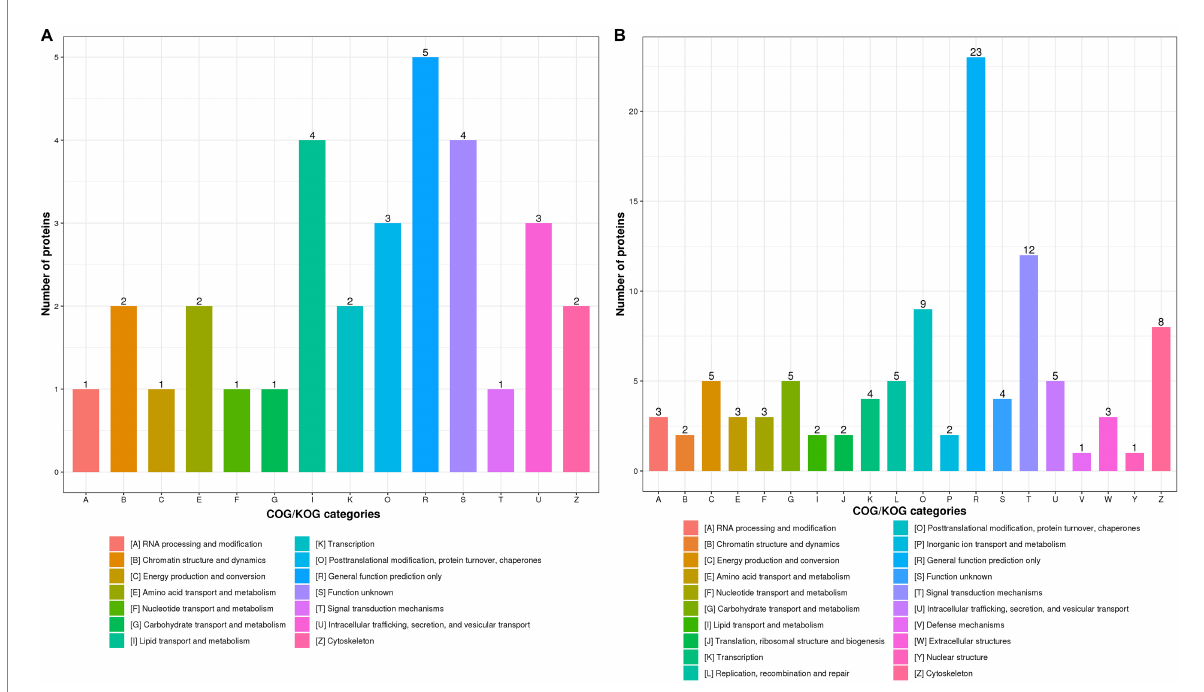
FIGURE 5 COG/KOG functional classification distribution maps of DEPS in WT and KO mice lung tissues infected with PR8 virus at 0 dpi (A) and 3 dpi (B) ,